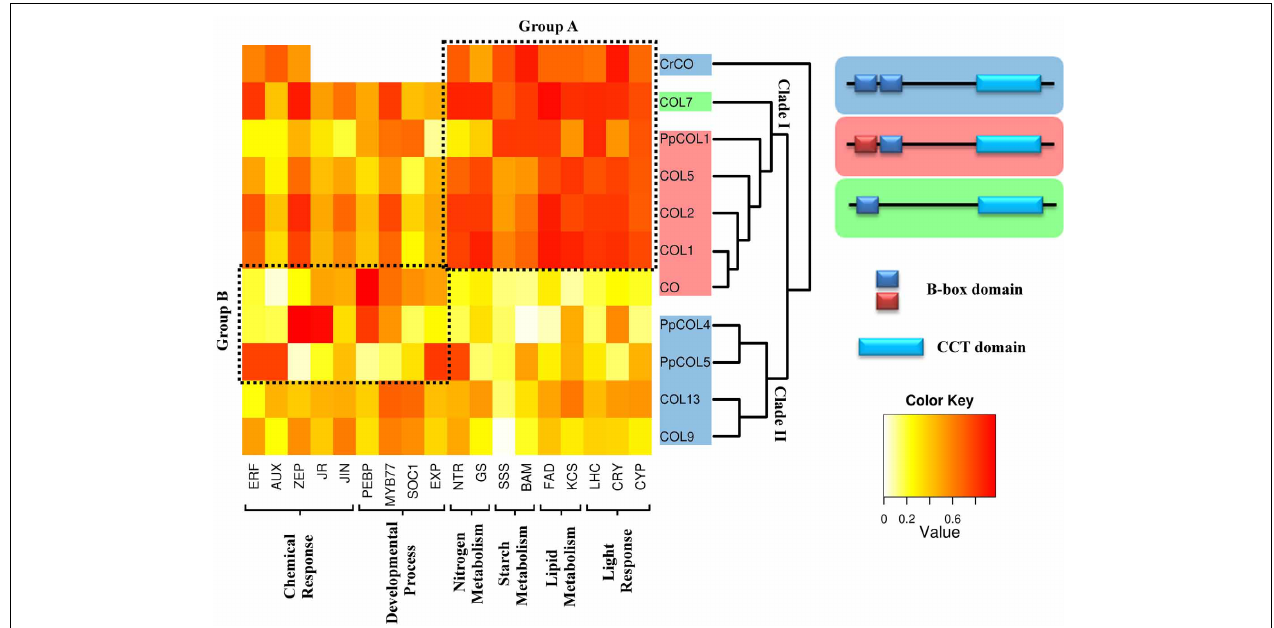
FIGURE 3 | Comparison of the gene co-expression analysis with a phylogenetic and domain conservation study. The analyzed CrCO, PpCOLs, and AtCOLs proteins are organized in the rows of a heatmap according to their phylogeny. Two big clades descending from CrCO can be observed. Clade I includes genes with a divergent and a normal B-box (PpCOL1, COL5, COL2, COL1, and CO), highlighted in red, and COL7 with a single B-Box. Clade II is composed of proteins with two similar B-boxes (PpCOL4, PpCOL5, COL13, and COL9). Representative clustered genes in biological processes in which COLs are involved were chosen. Dark red cells indicate a high correlation between